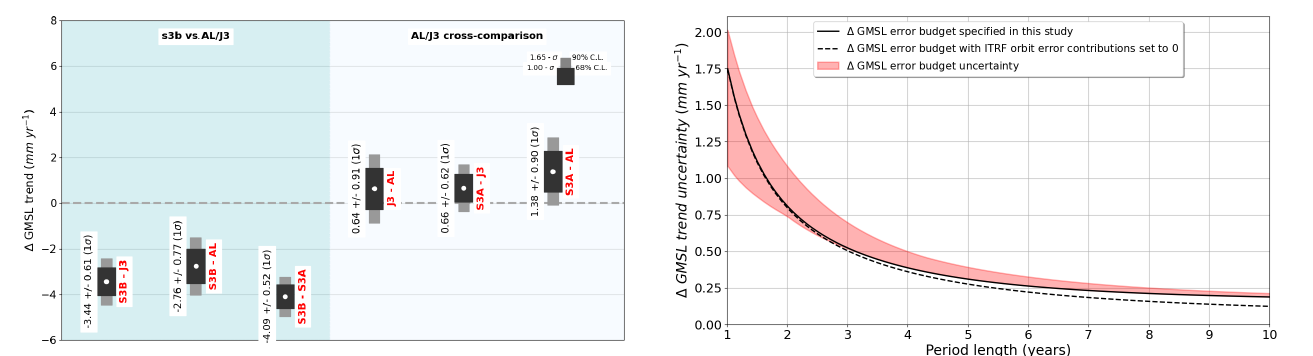
Figure 4. Evolution of GMSL trend uncertainties versus period length from the S3A and Jason-3 comparison. The solid black line is the GMSL trend uncertainty derived from the GMSL error bud- get (Table 1). The dotted black line is the GMSL trend uncertainty derived from the GMSL error budget (Table 1) with the orbit ITRF error contribution set to 0. The red envelope is the dispersion of GMSL trend uncertainty between the 5th percentile and 95th per- centile (i.e., 1 . 65 σ ) found by varying the cutoff frequency of the high-frequency errors from 0.5 to 6